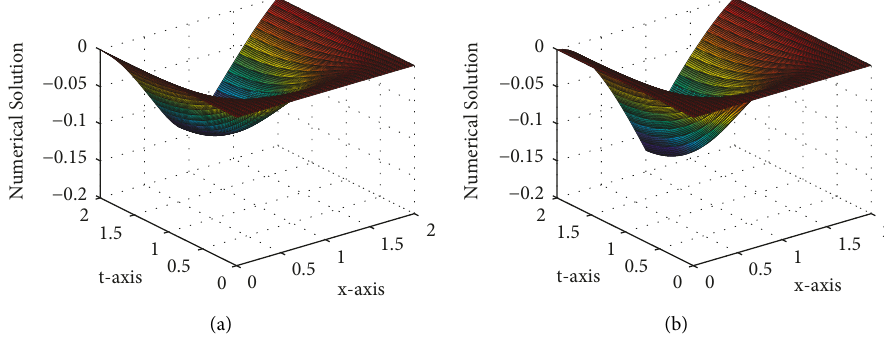
Figure 1: Surface plot of numerical solution of Example 1 at N � 32, M � 128. (a) ε � 10 0 , (b) ε � 10 − 4 .